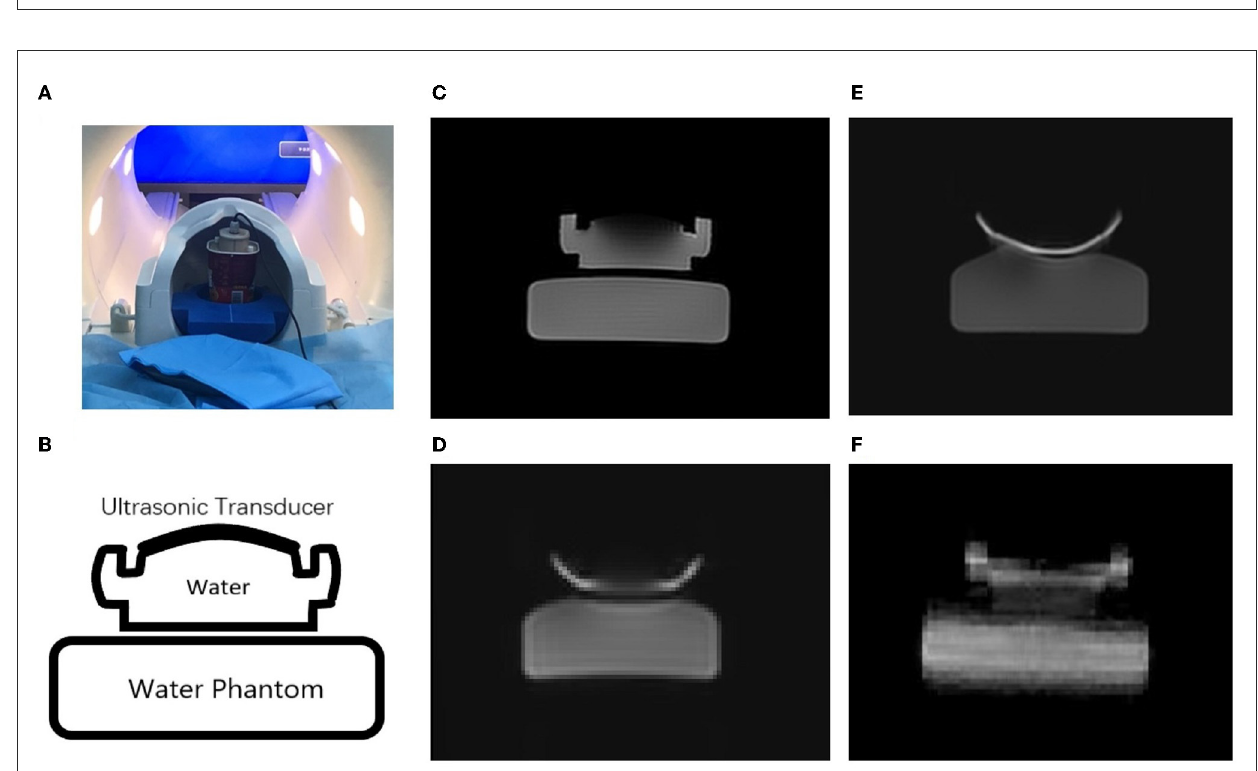
FIGURE2 Timing diagram of the SPEN-ARFI sequence used in this